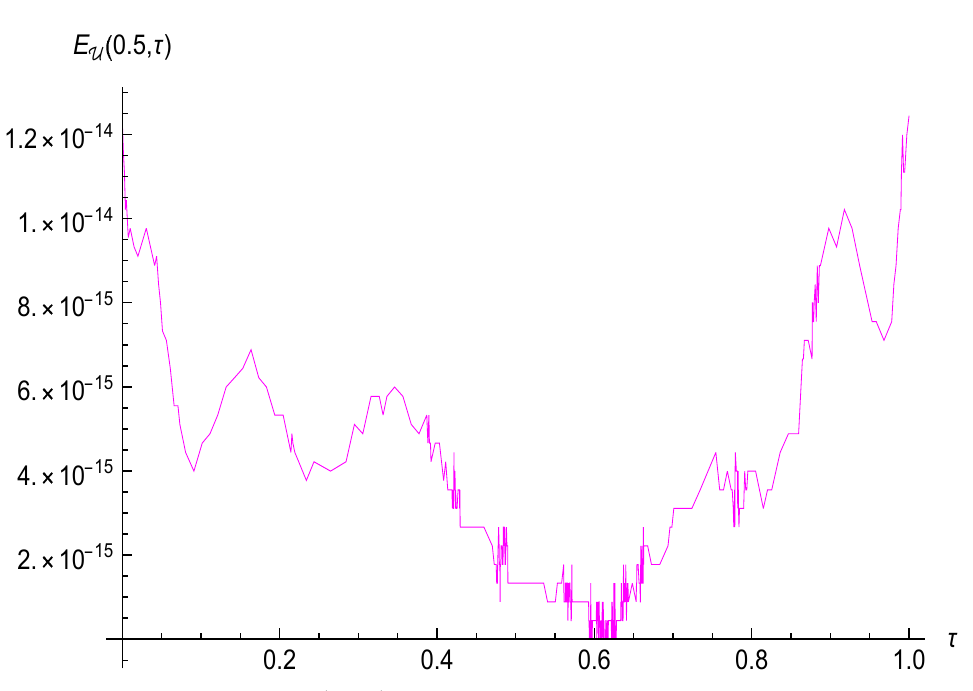
Figure 5. τ -Absolute errors E U ( 0.5, τ ) graph of the problem (30), where σ 1 = (cid:36) 1 = σ 2 = (cid:36) 2 = 0, ν = 0.5 and N = M = 16.